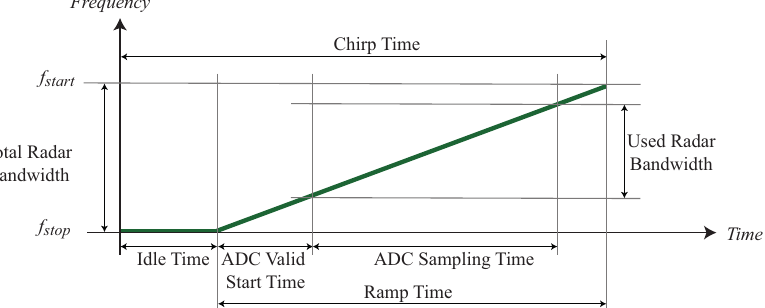
Figure 5. Graphical representation of the main parameters related to the radar signal